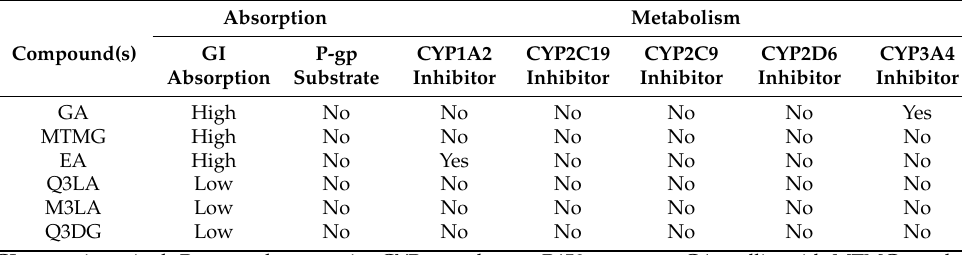
Table 6. Pharmacokinetic, i.e., absorption and metabolism profiles of the selected compounds from W. fruticosa leaves.